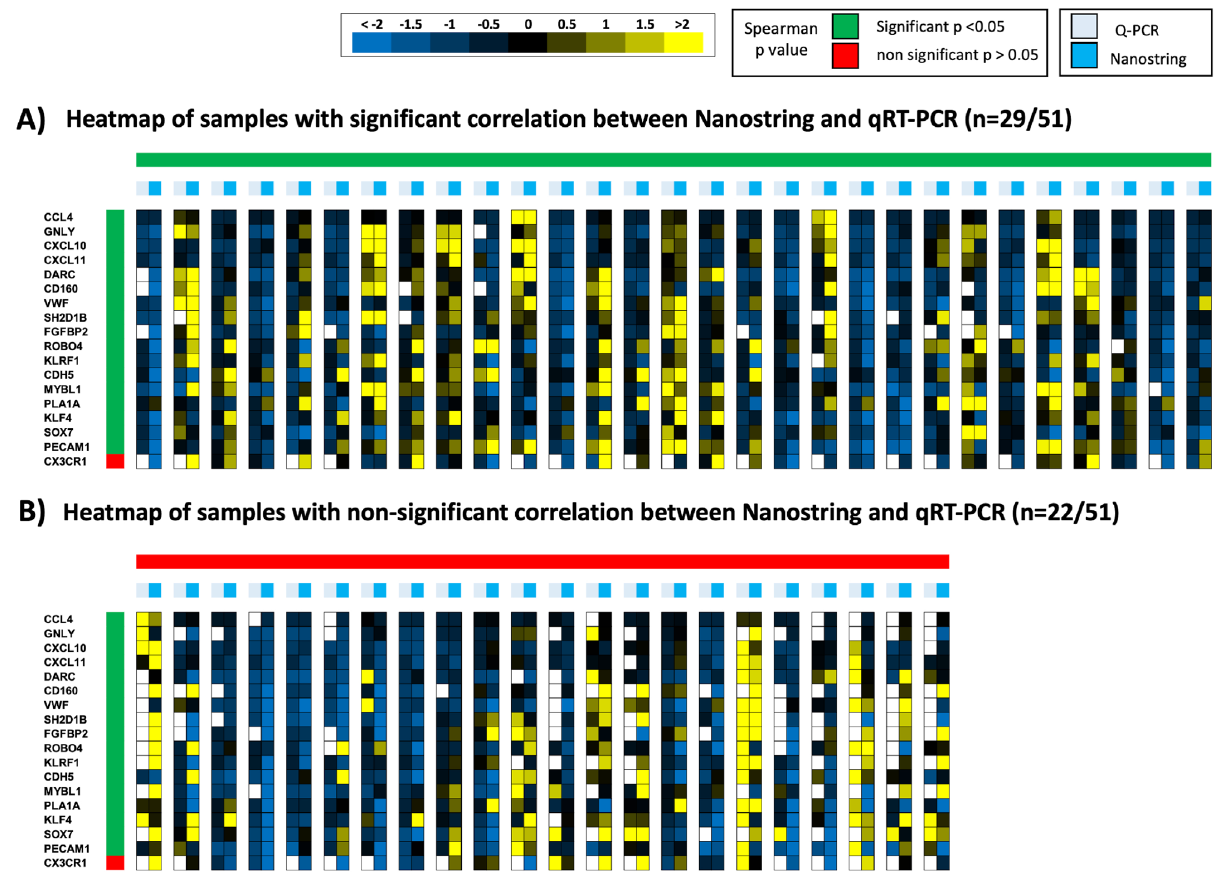
Figure 3. Representation by Heat Map of Z-score values from the same pool of RNA analyzed with NanoString versus qRT-PCR. Each row represents a gene, and each column represents a sample. Each column is double, with Z-scores in the NanoString analysis sample in light blue and Z-scores of the corresponding qRT-PCR dark blue. The heatmap color range is from yellow for positive Z-scores values to blue for Z-score negative values. Gene are ordered by their Spearman rank value (most significant on top; less significant at bottom). The white squares correspond to Non-Available data on qRT-PCR (NA) due to ct value higher than 34 or bad triplicate. Sample are grouped according to their Spearman rank p value: ( A ) samples with significant correlation between between NanoString and qRT-PCR for the expression of 18 genes, ( B ) samples with non-significant correlation between between NanoString and qRT-PCR for the expression of 18